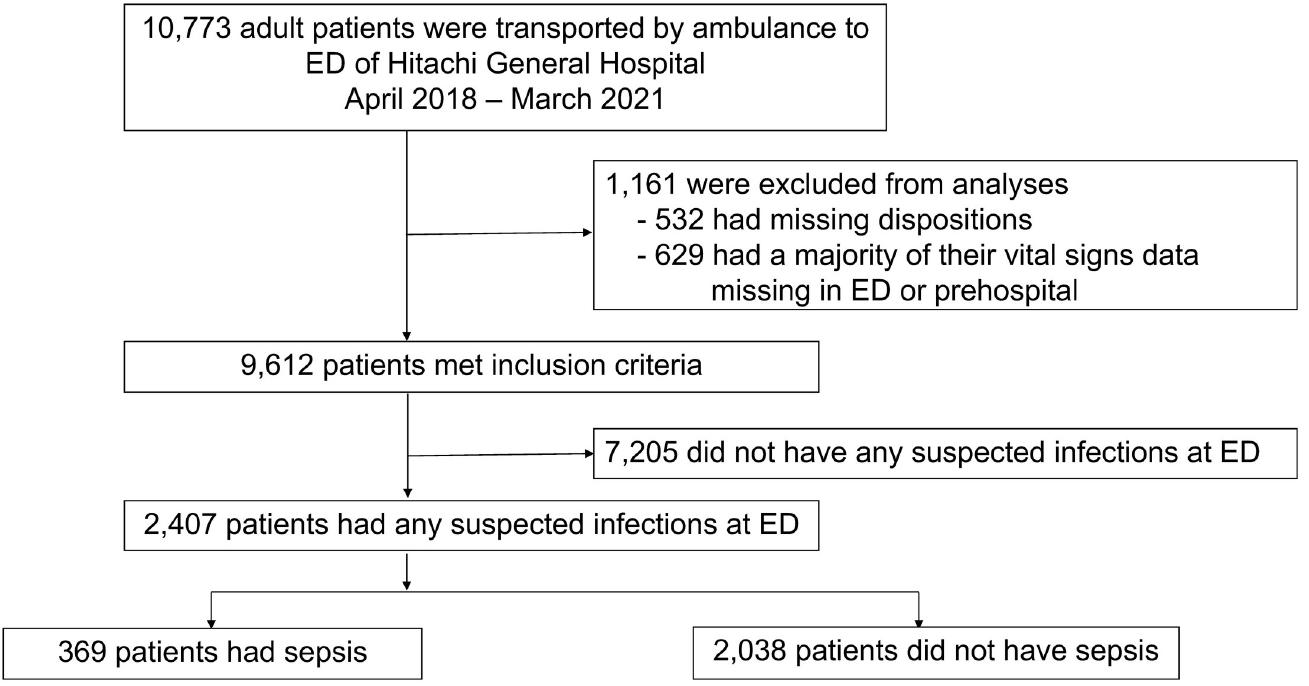
Fig 1. Flow diagram of study participants selection for analysis. Among 10,773 patients who were transported by ambulance to the ED of Hitachi General Hospital from April 2018 to March 2021, we identified 2,407 patients with suspected infection whose prehospital and ED vital signs data were available. Abbreviations: ED, Emergency